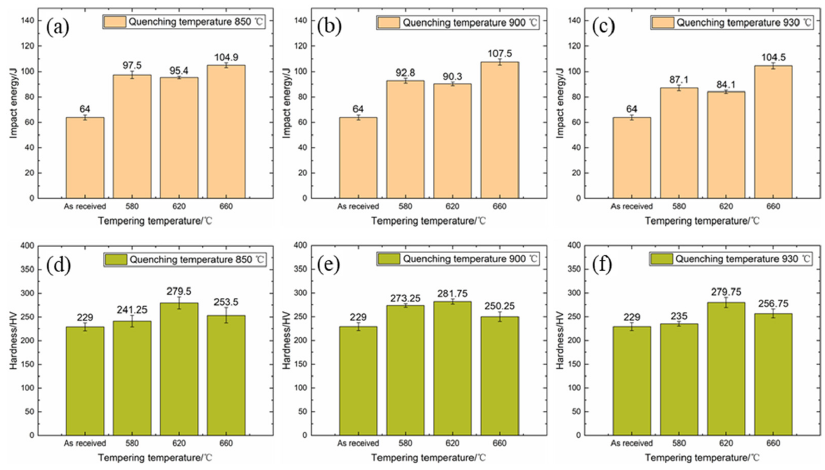
Figure 5. ( a – c ) Low-temperature ( − 40 °C) impact energy and ( d – e ) microhardness alterations with different quenching and tempering temperatures: ( a , d ) Q850 °C + T580, T620 and T660 °C, ( b , e ) with different quenching and tempering temperatures: ( a , d ) Q850 ◦ C + T580, T620 and T660 ◦ C, Q900 °C + T580, T620 and T660 °C, and ( c , f ) Q930 °C + T580, T620 and T660 °C. ( b , e ) Q900 ◦ C + T580, T620 and T660 ◦ C, and ( c , f ) Q930 ◦ C + T580, T620 and T660 ◦ By comparison, specimens treated with the highest quenching temperature (930 °C)